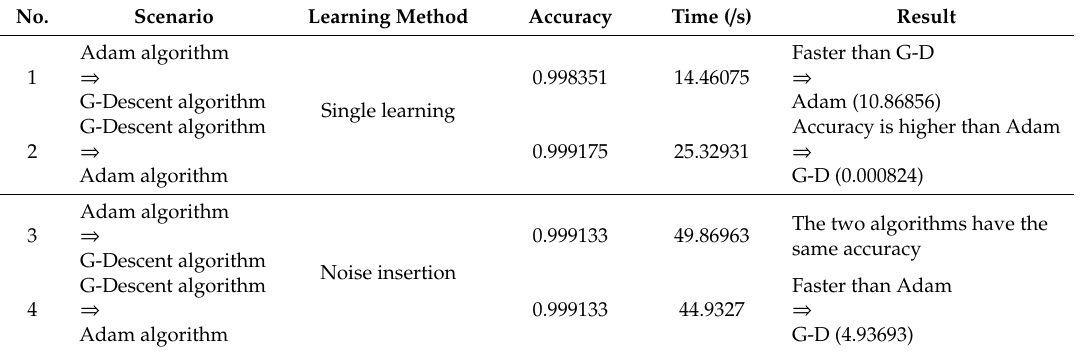
Table 6. Final result table obtained from 4 scenarios.